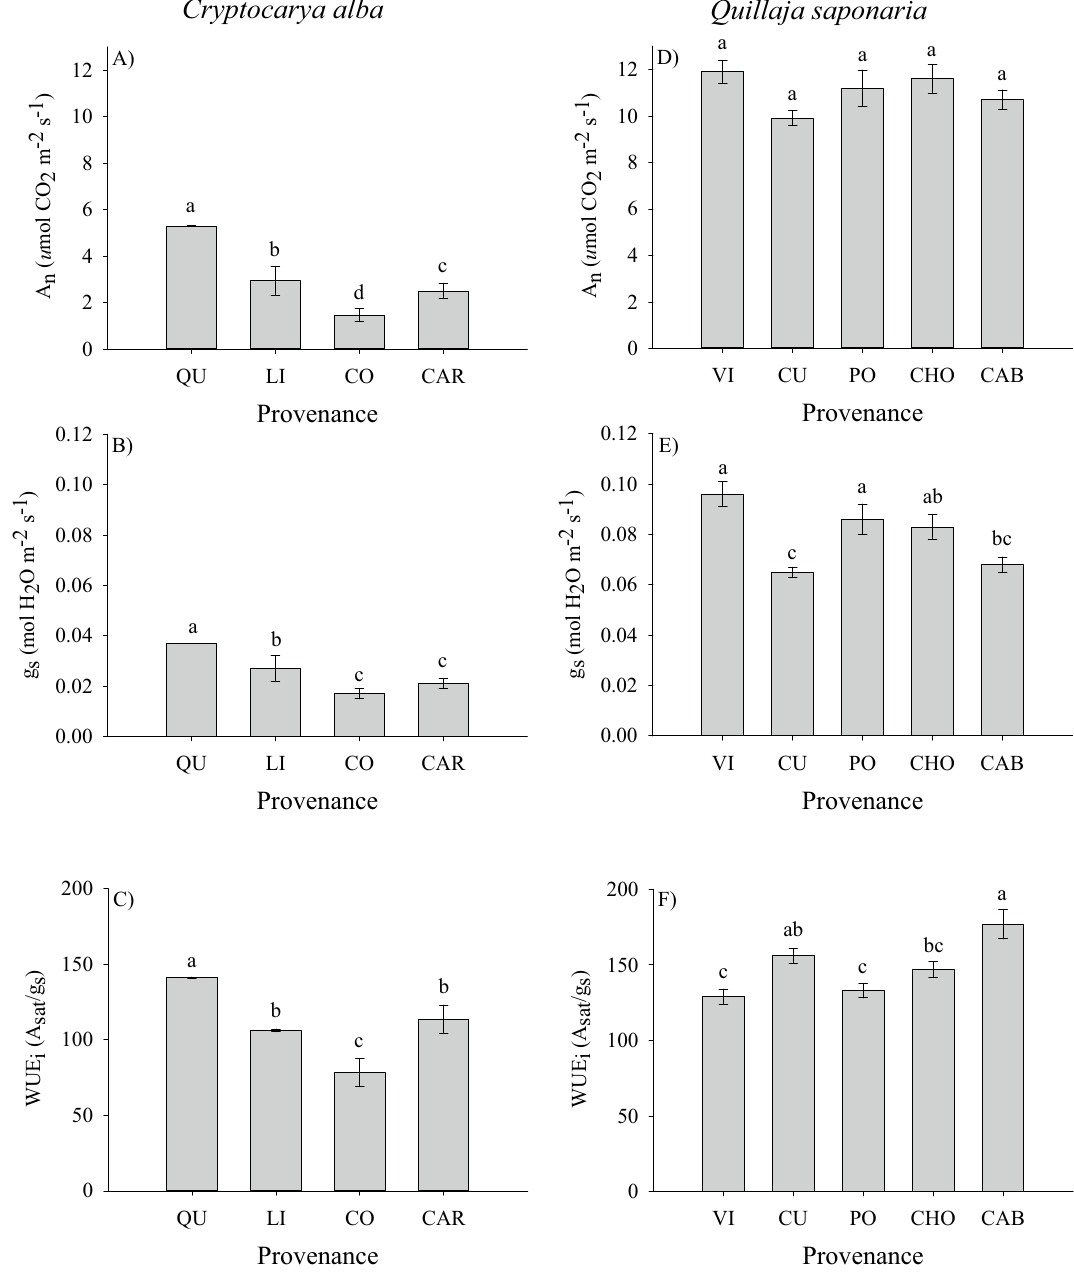
Figure 5. Gas exchange traits of C . alba and Q . saponaria seedlings according to the provenance. Different letters indicate significant differences among provenances (Tukey test; p ≤ 0.05). The error bars indicate the standard error. Codes for provenances are according to Table 1. Provenances are ordered from left to right by latitude of origin. In the case of C . alba , the provenance Hualañe (HU) had no alive seedlings after the post transplanting shock and this is why this provenance is missing from